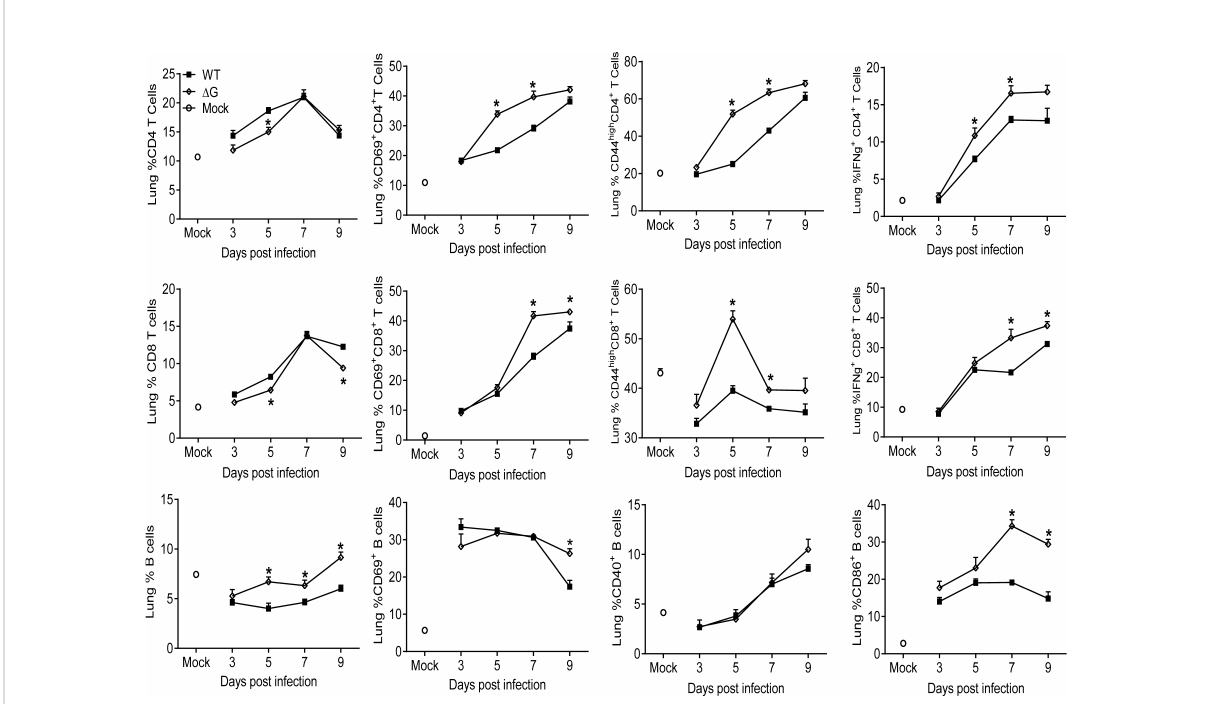
FIGURE 4 Lymphocyte recruitment and activation. Mice were either infected with rhMPV-WT or - D G or mock-infected and sacri fi ced at various time points p.i. to collect lungs. Single cell suspension of lungs was obtained and stained for CD4 (CD3 + CD4 + ) and CD8 (CD3 + CD8 + ) T cells and B cells (CD19 + B220 + ). Lymphocytes were further stained for expression of various activation markers (CD69, CD44, CD40, CD86). IFN- g produced by T cells was detected by intracellular staining upon stimulation with PMA/ionomycin and analyzed by fl ow cytometry. * P<0.05 when comparing rhMPV- D G infected mice to rhMPV- WT infected mice. rhMPV - D G = D G; rhMPV -WT =